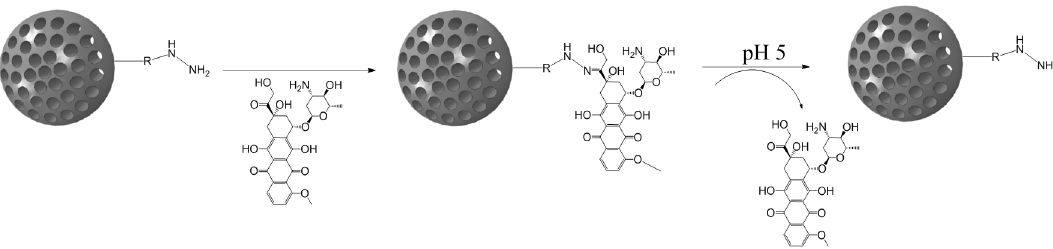
Figure 4. Mesoporous silica nanoparticle (MSN)-doxorubicin (DOX) via hydrazone bond on